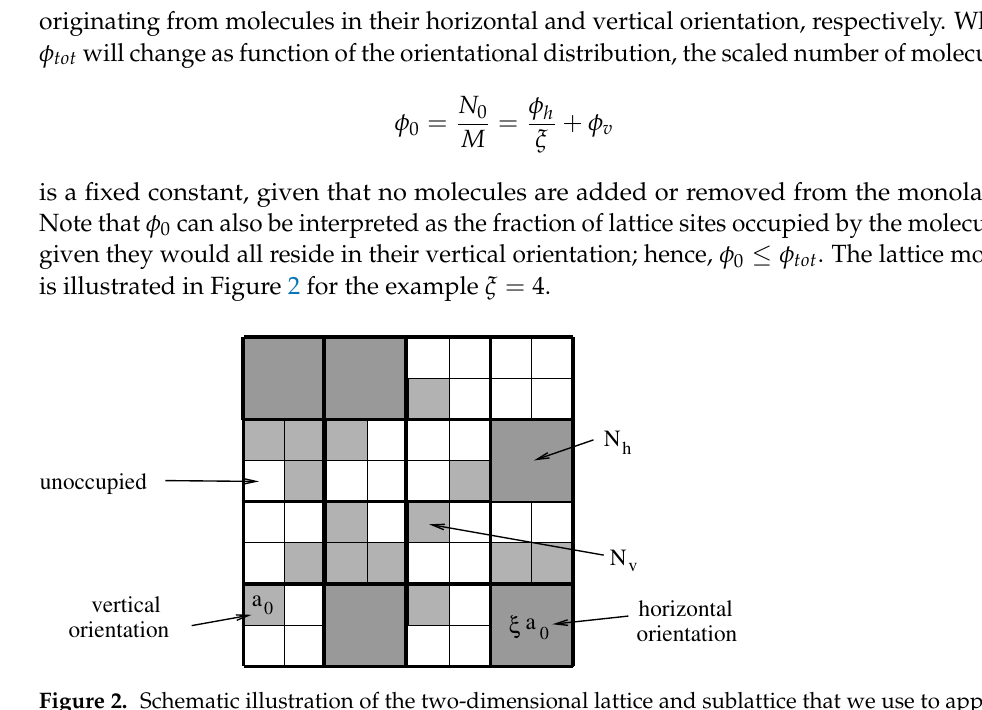
Figure 2. Schematic illustration of the two-dimensional lattice and sublattice that we use to approx- imate the number of states of the monolayer. The snapshot shows one specific configuration for M = 64, ξ = 4, N h = 5, and N v =